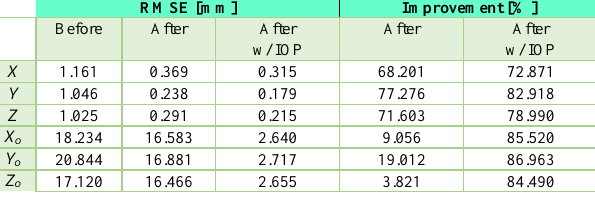
Table 8: In-sample errors of fluoroscopic system 1 and 2